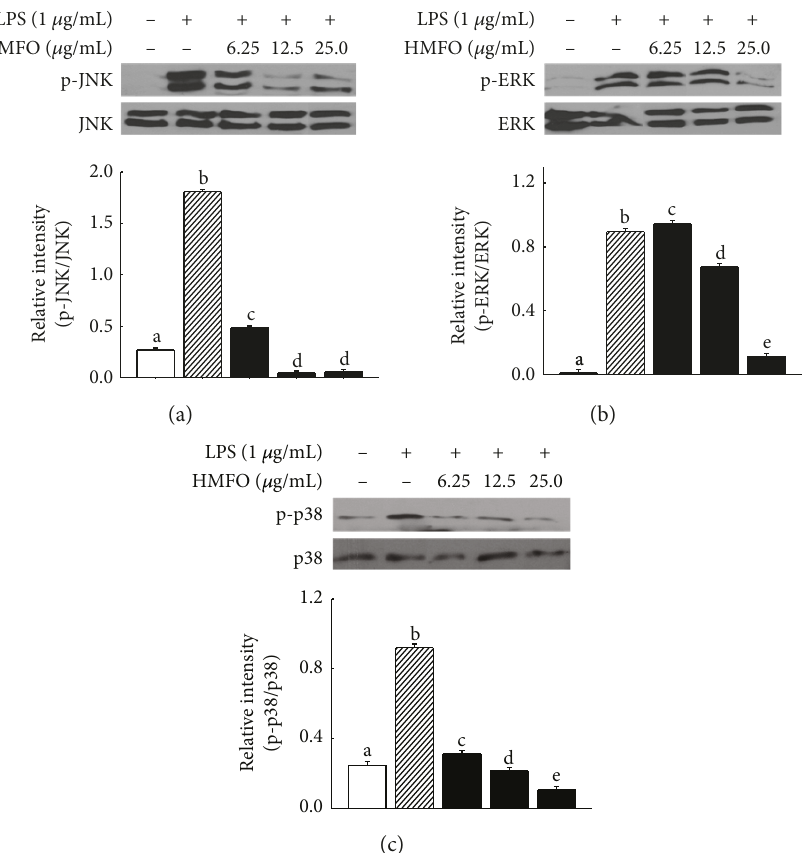
Figure 8: E ff ects of HMFO on MAPK signaling pathways in LPS-induced RAW 264.7 macrophages. RAW 264.7 macrophages were pretreated with di ff erent concentrations of HMFO for 2h and then stimulated with LPS for 22h. MAPKs and phosphorylated MAPKs were detected by Western blot analysis using antibodies against the corresponding MAPKs and phosphorylated (a) JNK, (b) ERK, and (c) p38 (activated forms), as described in Section 2.9. Values with di ff erent letters are signi fi cantly di ff erent ( p < 0 05